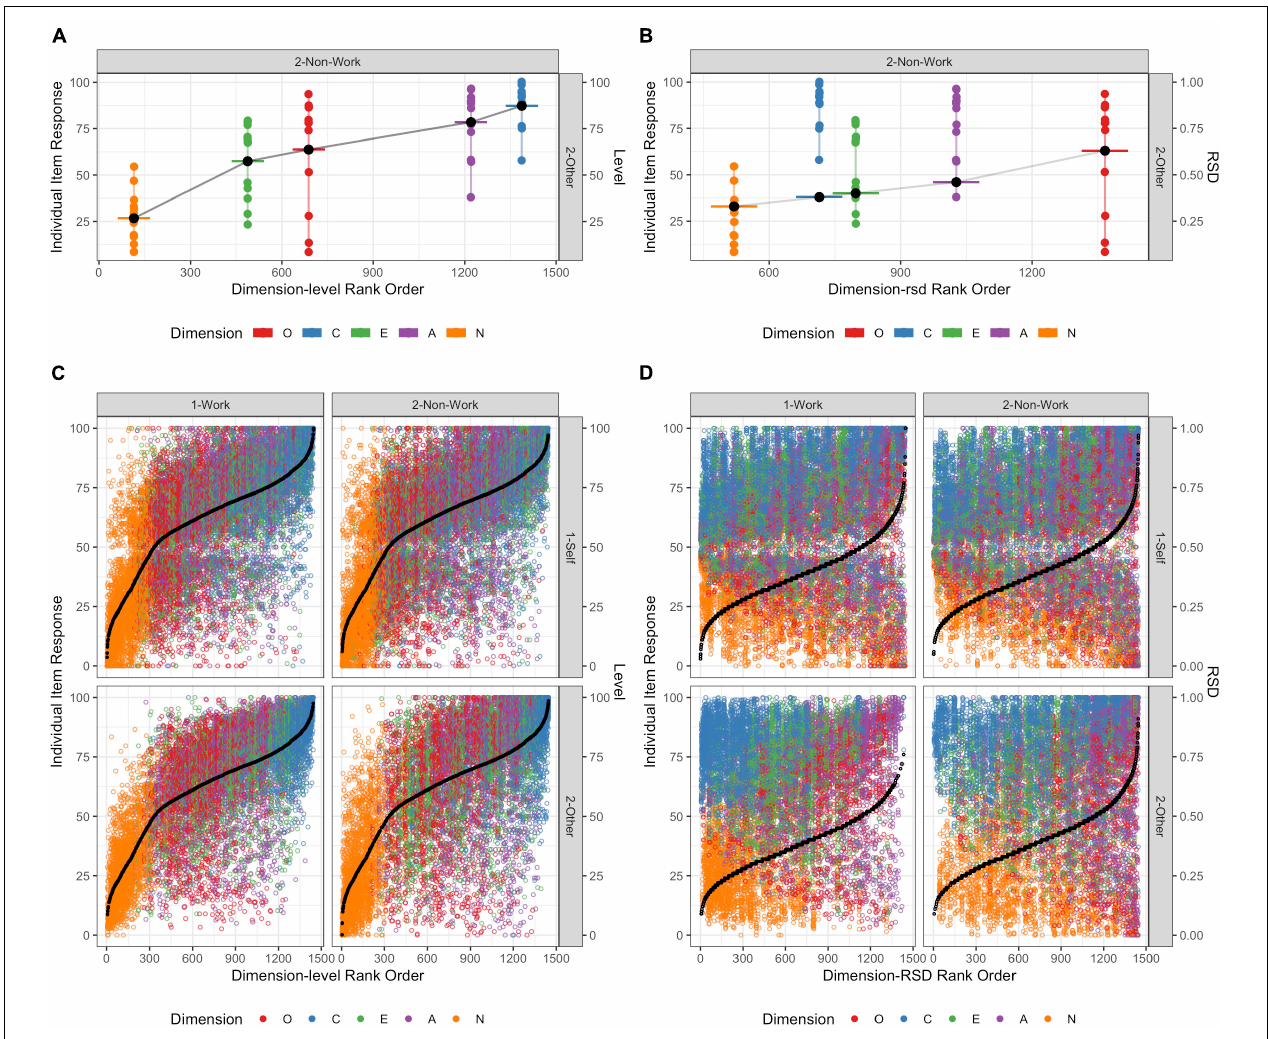
FIGURE 3 | Representation of response variability: Plot of item response by source (self vs. other) and context (work vs. non-work) for each item from five personality dimensions, ordered by (A,C) participant mean level, and (B,D) participant intra-individual variability (relative standard deviation, RSD). (A,B) Are for a randomly selected participant for illustration, whereas (C,D) are for all